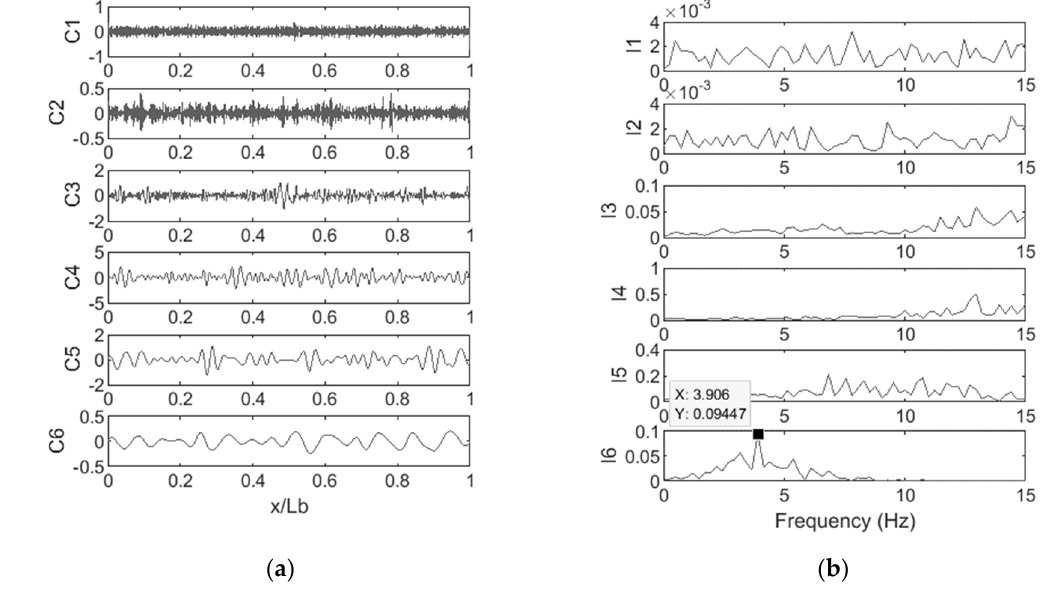
Figure 12. ( a ) IMFs of the vehicle acceleration response and ( b ) FFT of IMFs when the vehicle speed is 10 m/s.